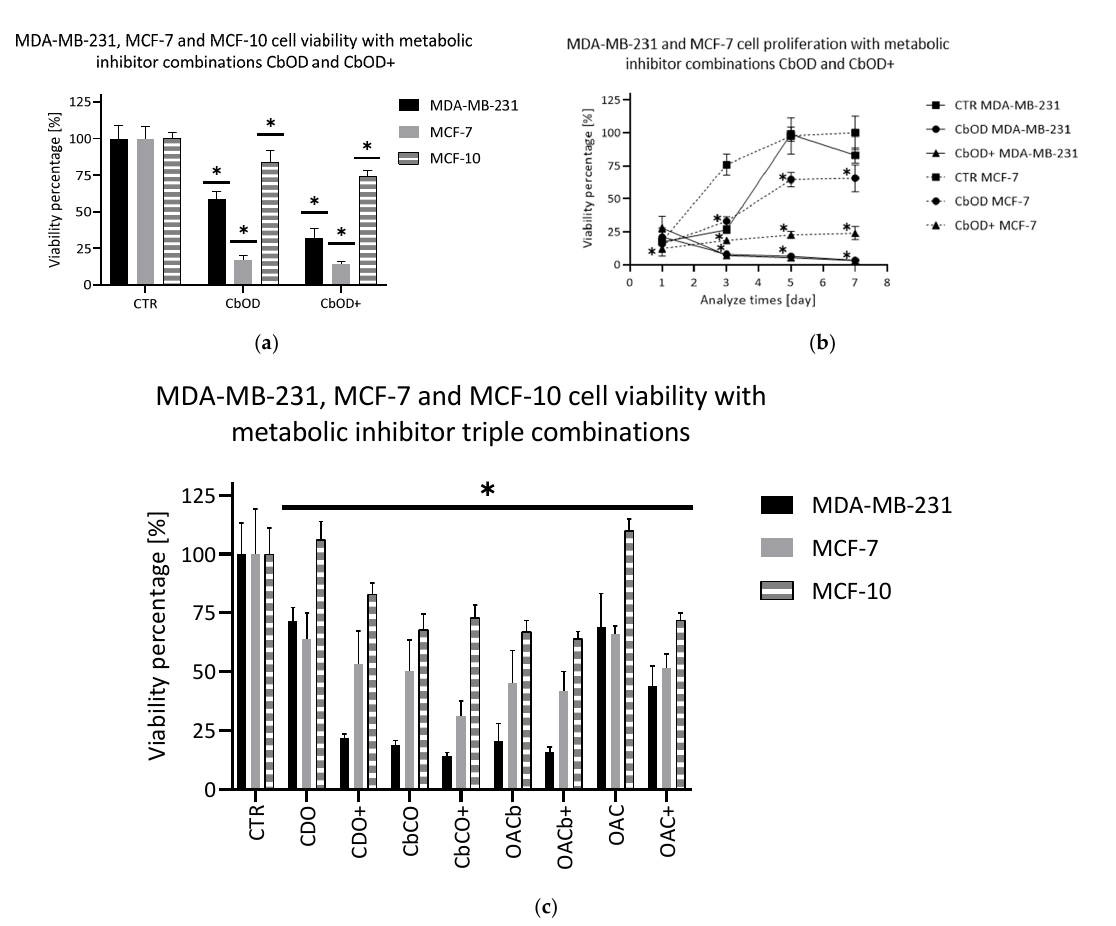
Figure 4. CbOD triple metabolic inhibitor combination evaluation. ( a ) Viability test (crystal violet staining) after 72 h. Black: MDA-MB-231, Grey: MCF-7 and Hatched: MCF-10. ( b ) Proliferation test (crystal violet staining) during 7 days of measuring at days 1, 3, 5 and 7. Full lines: MDA-MB-231 and Hatched lines: MCF-7. ( c ) Viability test (crystal violet staining) after 72 h. Black: MDA-MB-231, Grey: MCF-7 and Hatched: MCF-10. Conditions: CTR: control condition; CbOD: CB-839 50 nM, Oxamate 20 mM and D609 25 µM; CbOD+: CB-839 1 µM, Oxamate 50 mM and D609 75 µM; CDO: Chrysin 1 µM, D609 25 µM and Oxamate 20 mM; CDO+: Chrysin 5 µM, D609 75 µM and Oxamate 50 mM; CbCO: CB-839 50 nM, Chrysin 1 µM and Oxamate 20 mM; CbCO+: CB-839 1 µM, Chrysin 5 µM and Oxamate 50 mM; OACb: Oxamate 50 mM, AZD3965 5 nM and CB-839 50 nM; OACb+: Oxamate 50 mM, AZD3965 50 nM and CB-839 1 µM; OAC: Oxamate 20 mM, AZD3965 5 nM and Chrysin 1 µM and OAC+: Oxamate 50 mM, AZD3965 50 nM and Chrysin 5 µM; n = 6, average ± SD, significance: * p < 0.05.